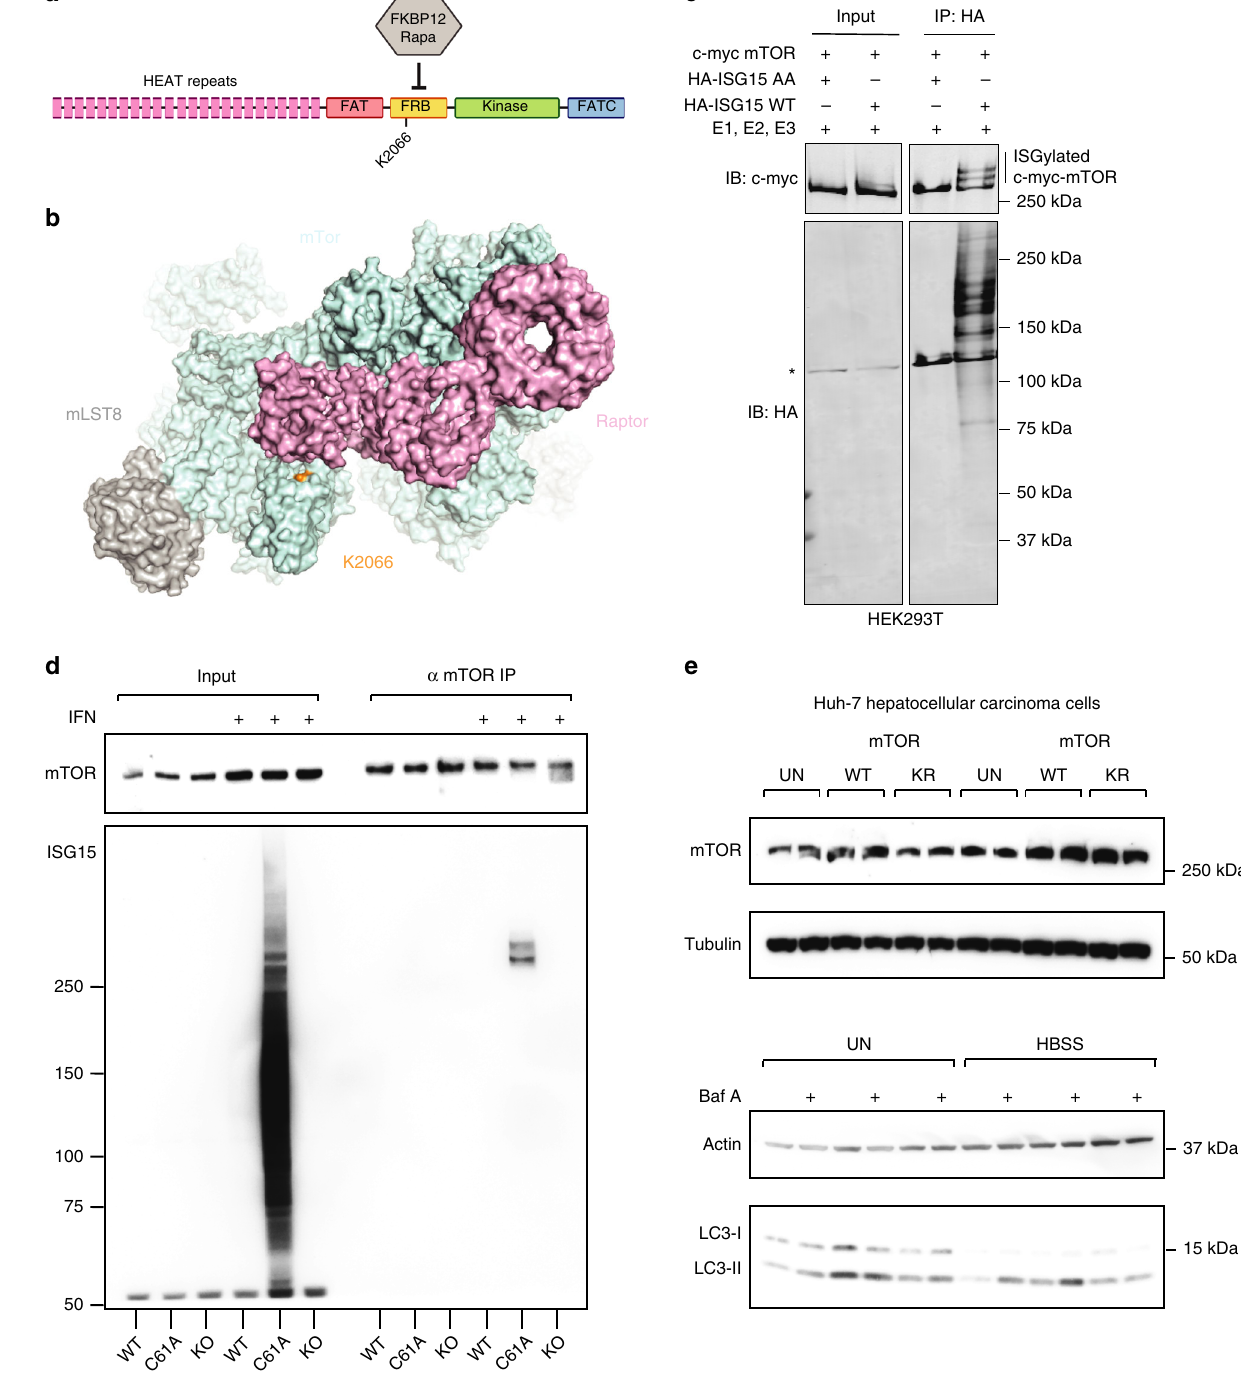
Fig. 6 mTOR is modi fi ed by ISG15 and mutation of K2066 to arginine results in reduced autophagy. a Schematic of the domains of mTOR with the target lysine highlighted. b ISGylated site Lys2066 of serine/threonine-protein kinase mTOR (uniprot ID: Q9JLN9) is shown in orange on the structure PDB 5H64 [https://www.rcsb.org/structure/5H64] 73 . c Validation of modi fi cation of mTOR by ISG15 in HEK293T overexpression system (simultaneous overexpression of E1, E2, E3, mTOR, and ISG15, either wild-type or non-conjugatable ISG15AA); asterisk indicates FLAG-HERC5; SDS-PAGE of input and immunoprecipitation of ISG15. d Validation of endogenous modi fi cation of mTOR by ISG15 in mouse embryonic fi broblasts treated with Type I IFN (1000 units/mL) for 24 h. Immunoprecipitation of endogenous mTOR and SDS-PAGE for both mTOR and ISG15. Modi fi ed ISG15 is only detectable in USP18 C61A/ C61A MEFs. The experiment was repeated three times, and one representative blot is shown. e Ectopic expression of either wild-type mTOR (WT) or